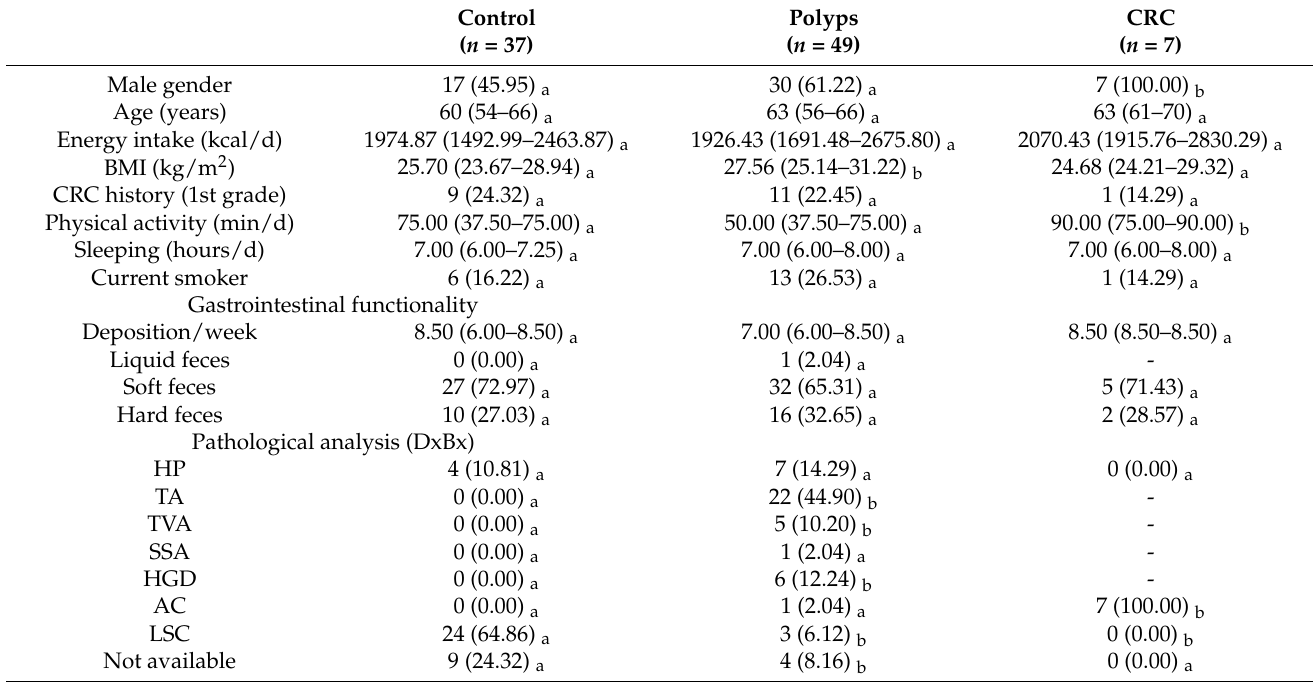
Table 1. General description of the sample population according to diagnosis